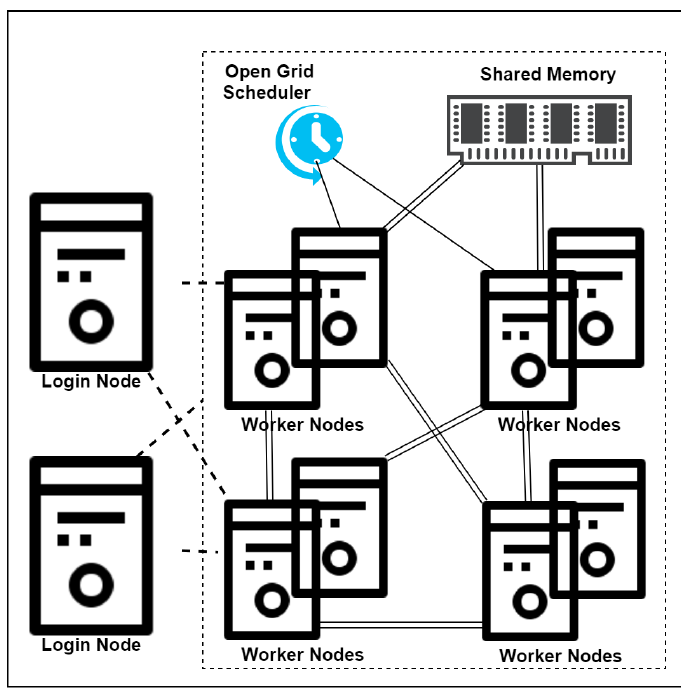
Figure 3. Overview of the Eddie architecture [34]. The login node has limited memory and allows users to submit batch jobs or to start an interactive session. The submitted jobs run on the assigned worker nodes connected through a 10 Gbps Ethernet network shown by double lines.